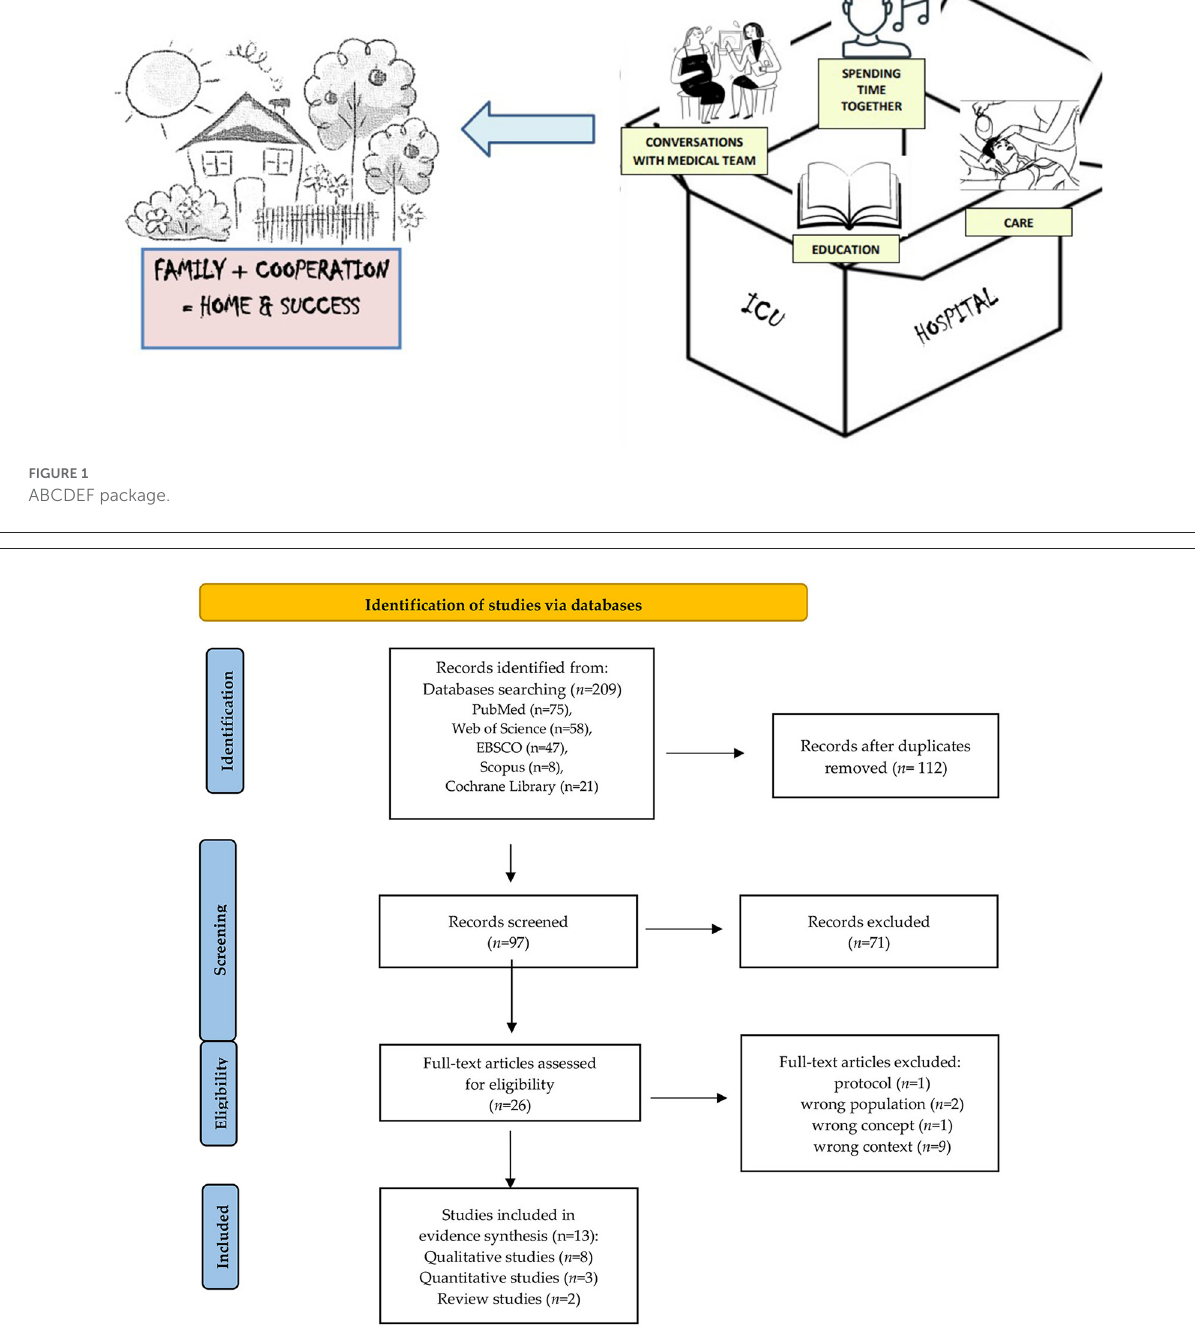
FIGURE2 PRISMA flow diagram